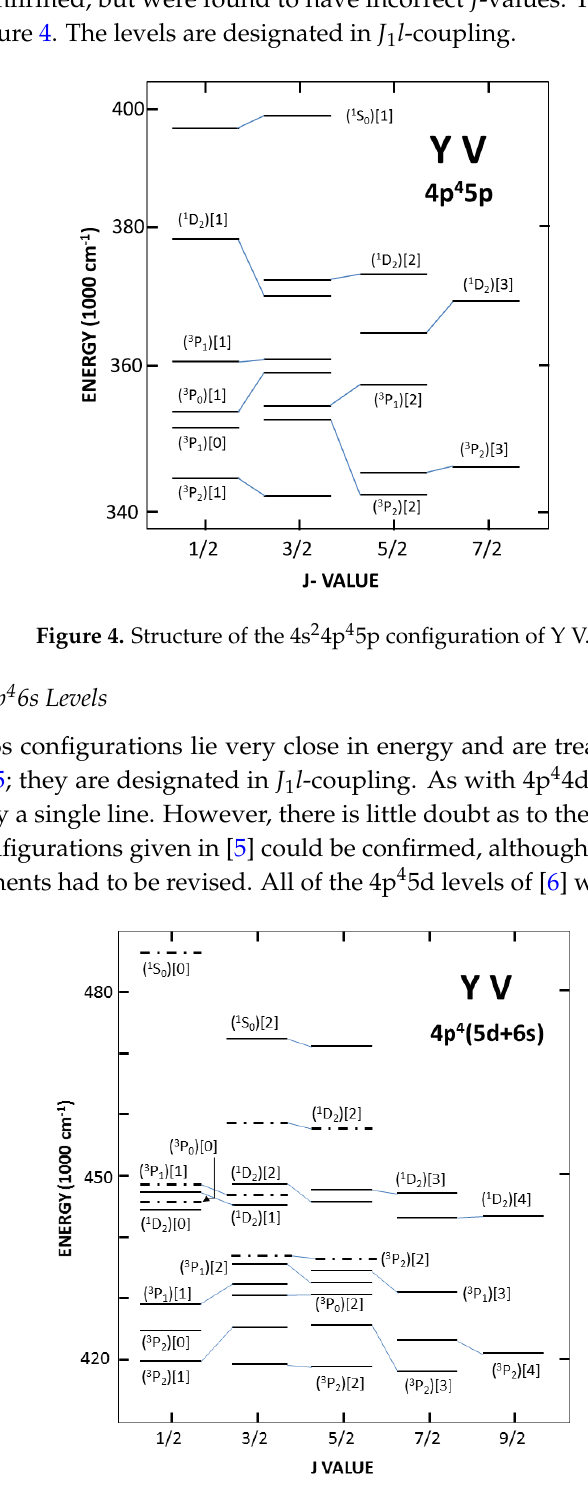
Figure 3. Structure of the 4s 2 4p 4 5s configuration of Y V.